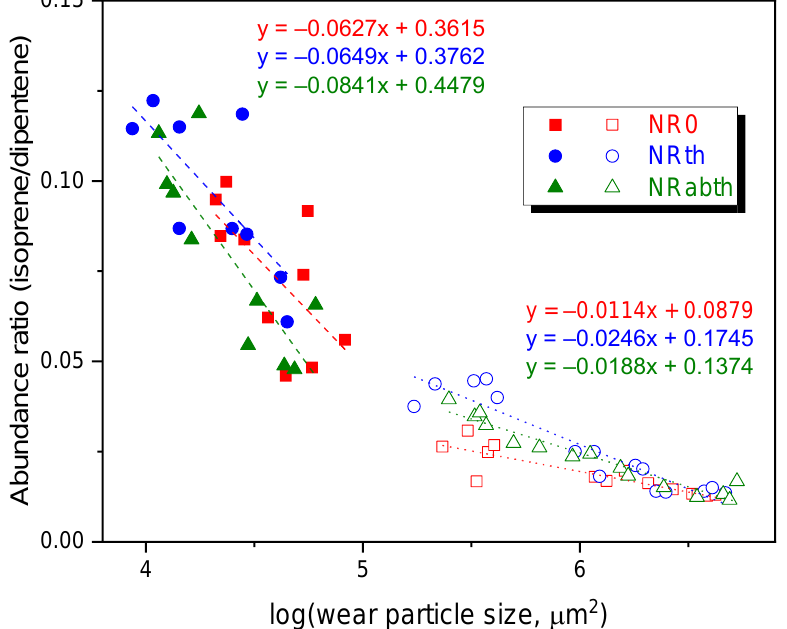
Figure 5. Variations of the isoprene/dipentene ratios of the wear particles with the logarithmic wear particle size. The wear particle size is the multiplication of the major and minor axes. The squares, circles, and triangles denote the wear particles of NR0, NRth, and NRabth samples, respectively.